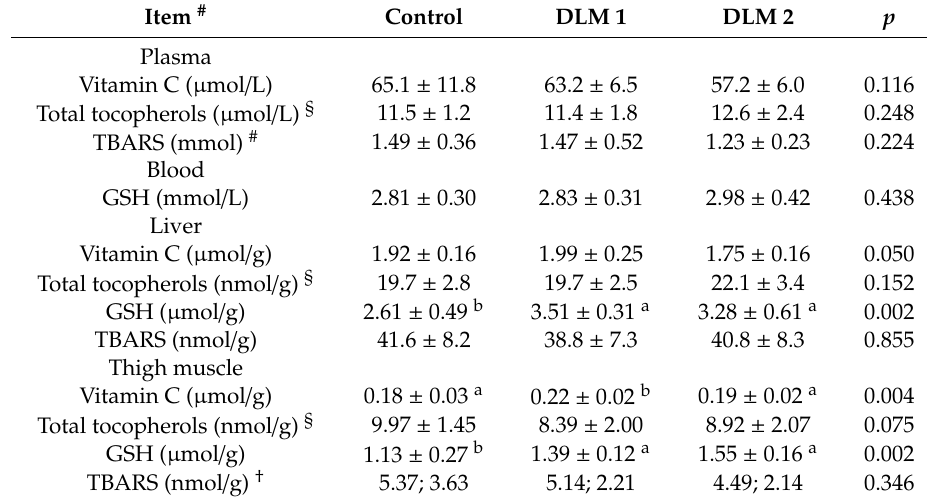
Table 4. Concentrations of antioxidants and oxidation products in plasma, blood, liver, and thigh muscle of broilers fed a control diet or diets supplemented with two di ff erent levels of DL-methionine (DLM 1 and DLM 2) * , ‡